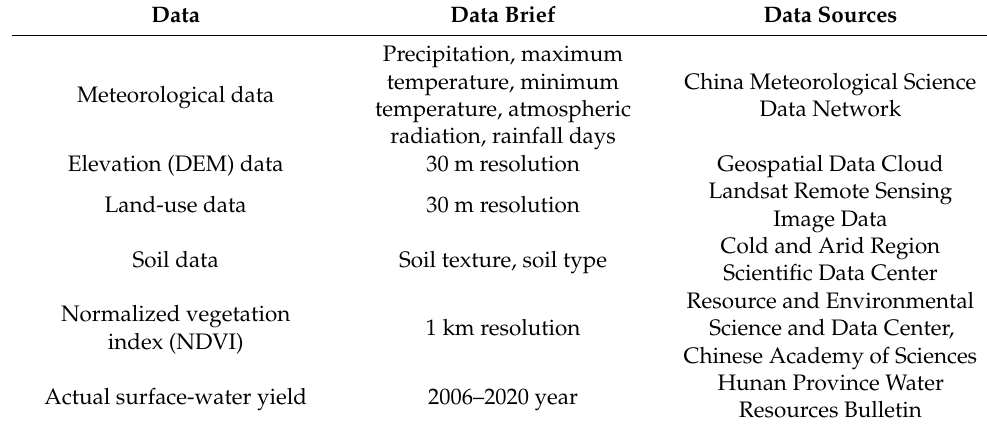
Table 1. Data information and sources.